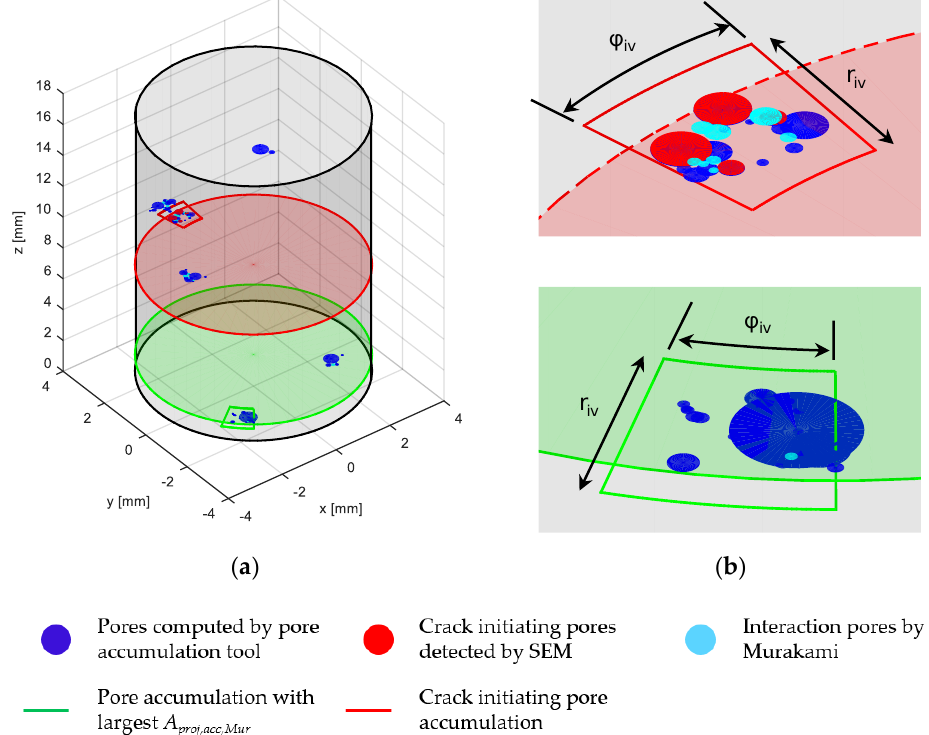
Figure 13. ( a ) Computed pore accumulations in terms of A proj for specimen No. 04; ( b ) Detail view of the crack-initiating pore accumulation including crack-initiating pores detected by SEM (top) and the pore accumulation with the largest computed A proj,acc,Mur (bottom).